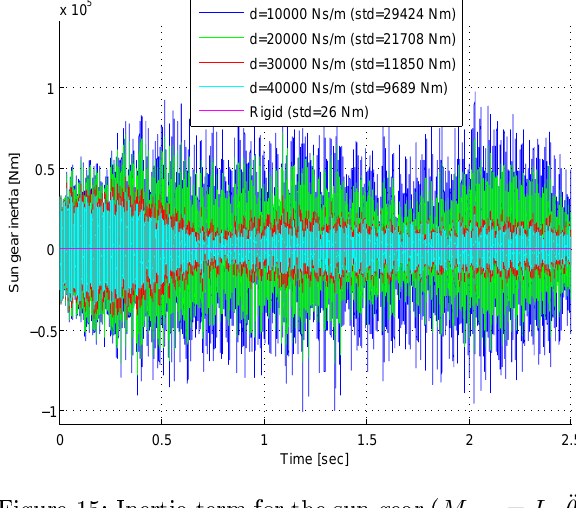
Figure 15: Inertia term for the sun gear ( M sun = I zz ¨ θ ) using di(cid:27)erent damping coe(cid:30)cients, for the realistic planetary gearbox in a 500 kW wind